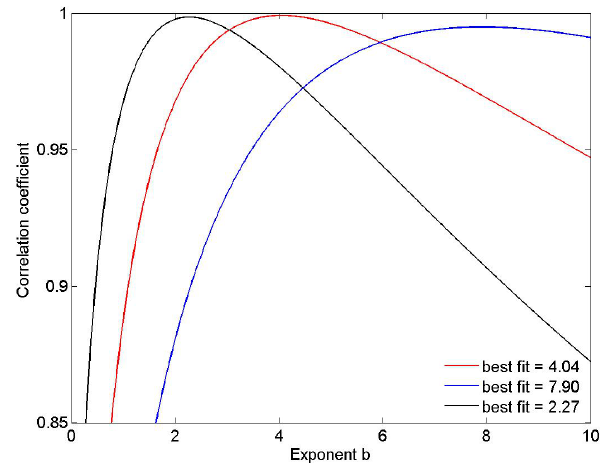
Fig. 6. Correlation coefficient as a function of exponent b when fit- ting N 3 ∼ [H 2 SO 4 ] b for three example cases each simulated using nucleation mechanism J 1 . 5 = Q × [H 2 SO 4 ] 4 . The legend indicates the best fit exponent, i.e. value of b that has the highest correlation coefficient, in each